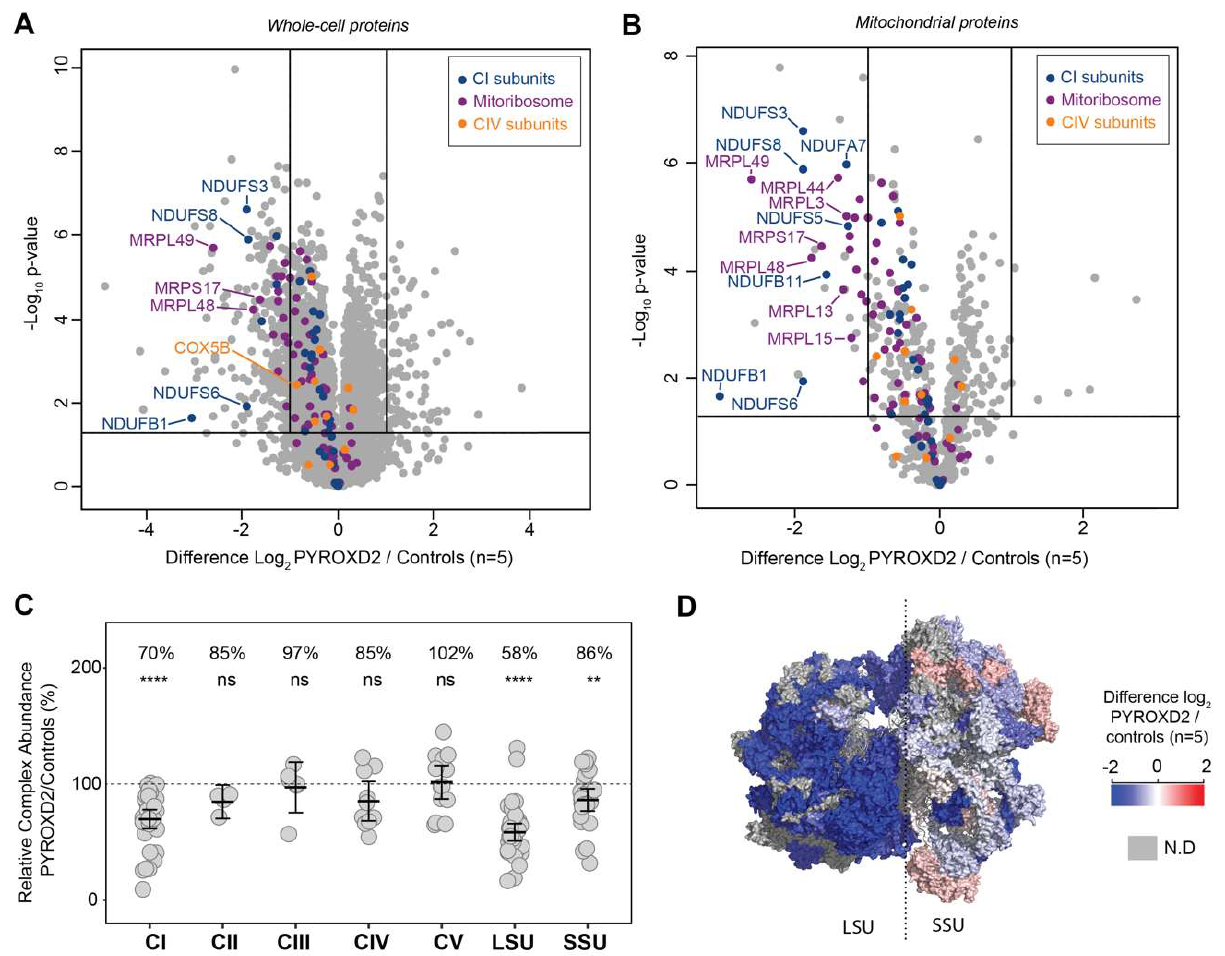
Figure 4. Quantitative proteomics from patient fibroblasts indicate a complex I and mitoribo- some defect . Complex I subunits and proteins belonging to the mitoribosome are decreased in the PYROXD2 patient relative to controls, suggesting a mitoribosome defect. ( A ) The volcano plot of the whole-cell fibroblast proteins, and the ( B ) volcano plot of the mitochondrial proteins (filtered in silico from MitoCarta 3.0 annotation) depicting the differences between the PYROXD2 patient and the controls ( n = 5). Significance lines were set to log2 = ± 1 (equivalent to fold-change ± 2) and p -value = 0.05 equivalent. ( C ) The relative complex abundance (RCA) plot of the OXPHOS complexes and mitoribosome subunits depicting CI, LSU, and SSU defects. The graph represents each complex ratio of PYROXD2/controls with a 95% confidence interval. p -value 0.05, **: p ≤ 0.01, ****: p ≤ 0.0001, ns: non-significant. ( D ) Topographical mapping of the relative abundances mapped to the mitoribo- some structure depicting areas of decreased abundance. PDB id: 3J9M.